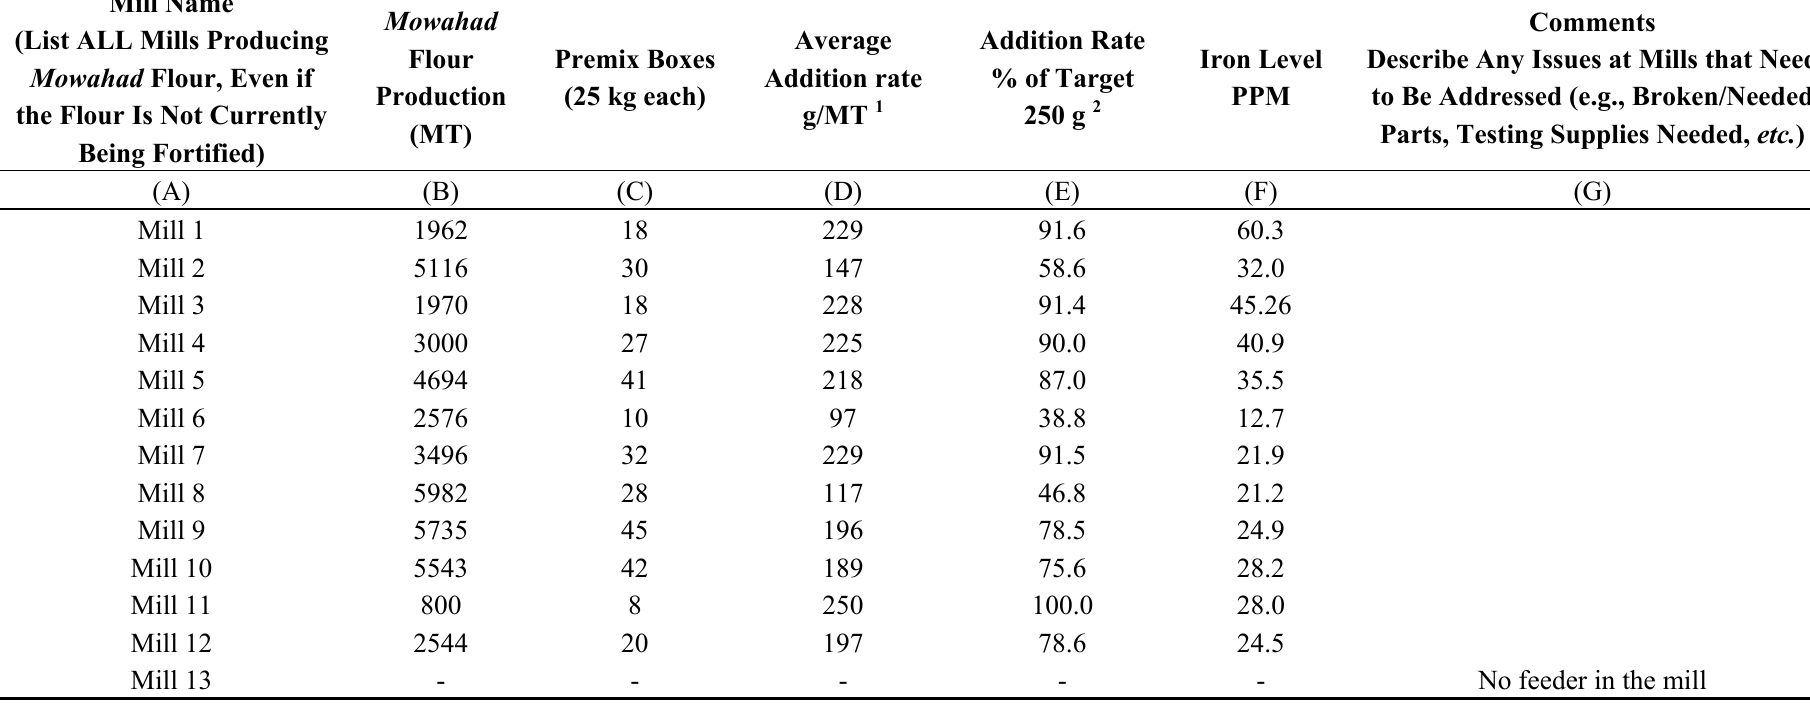
Table 3. Example of monthly food fortification monitoring report. (February 1–28,